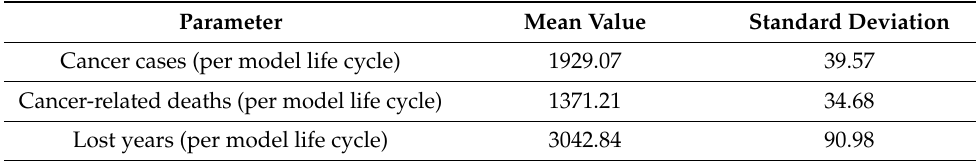
Table 1. Current scenario modeling results.